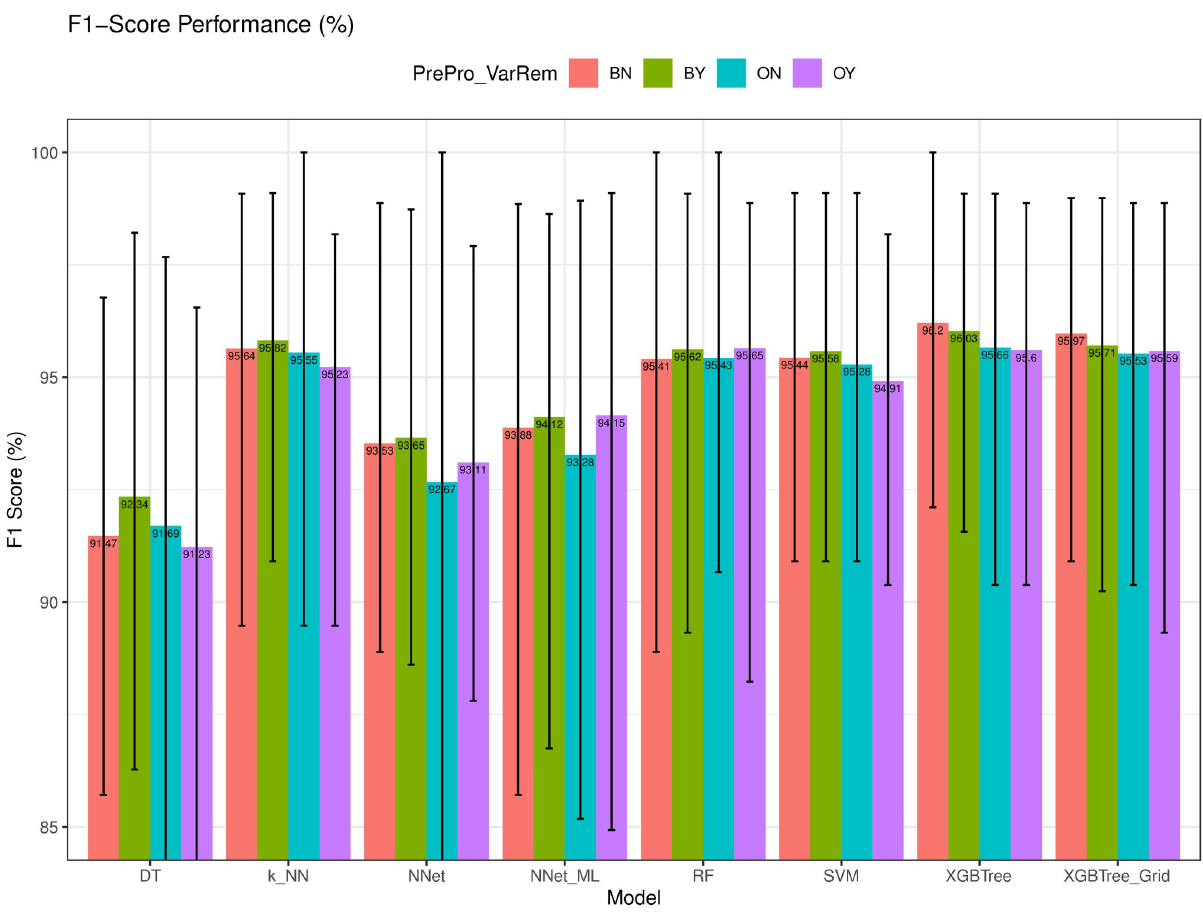
Fig 13. F1-score ( F1-score ) of different models.